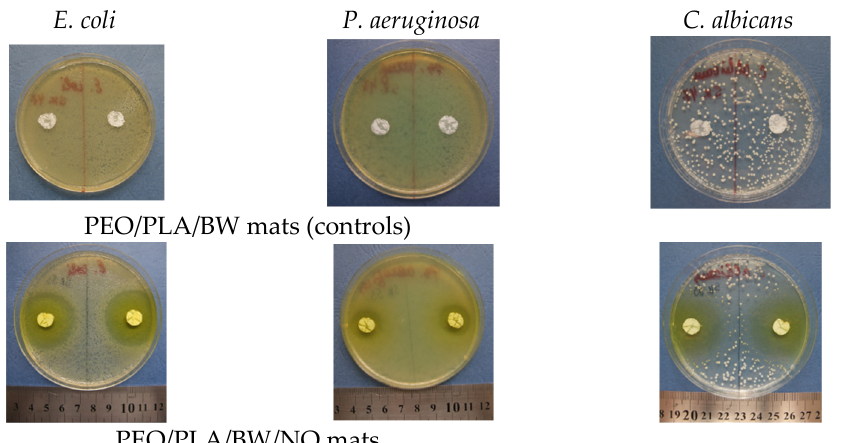
Figure 10. Digital images of the inhibition zones detected after a 24 h contact of PEO(50)/PLA(25)/BW(25)/NQ mats with S. aureus , E. coli or P. aeruginosa cells or after a 48 h contact with C. albicans (lower row). For comparison, images of Petri dishes with blank control PEO(50)/PLA(25)/BW(25) mats are presented on the upper row. Table 3. Inhibition zones determined after a 24 h contact of PEO/BW/PLA/NQ mats with S. aureus , E. coli , P. aeruginosa or after a 48 h contact with C. albicans . Specimen